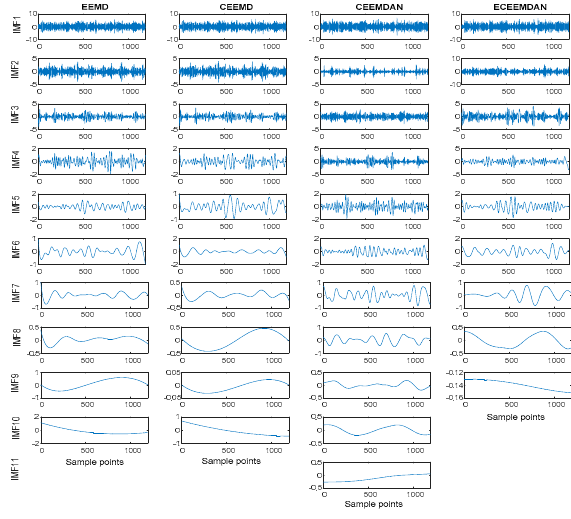
Figure 13. Decomposing result of SVS signal with the improved EMD versions and ECEEMDAN.